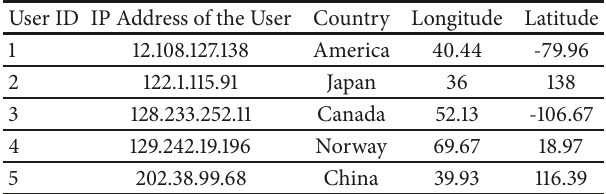
Table 2: Original location information of users.